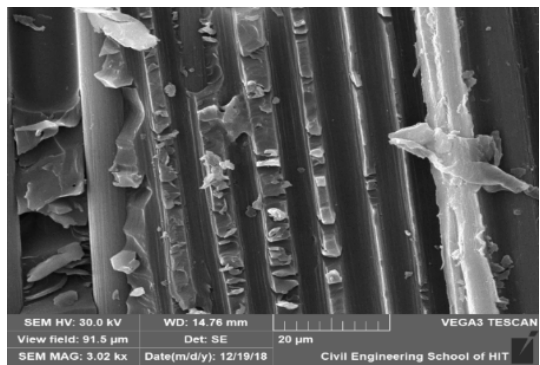
Figure 7. SEM image of the polymer matrix degradation of the composite in HCl solution.